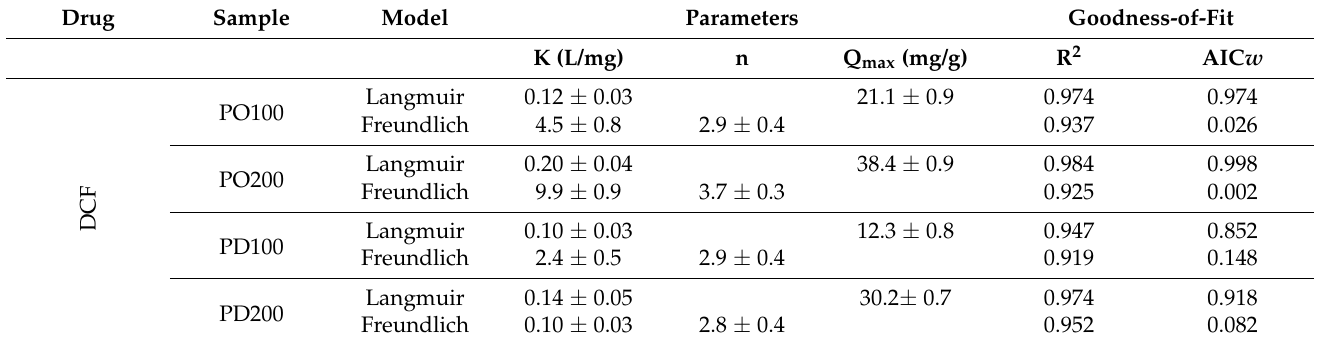
Table 2. Mathematical models for the adsorption isotherms: parameters and goodness-of-fit. Drug